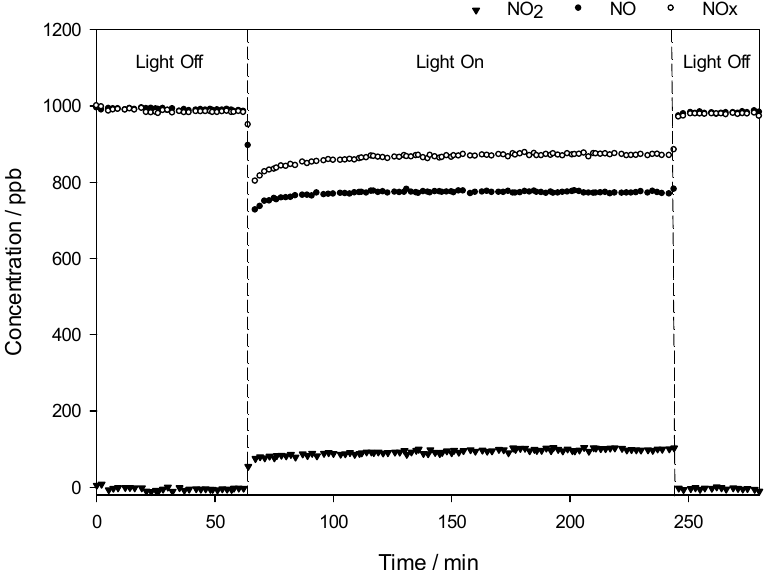
Figure 7. Changes in the concentrations of nitrogen oxides, i.e., NO, NO 2 , and NOx, as a function of time in the presence of the QT10 sample.